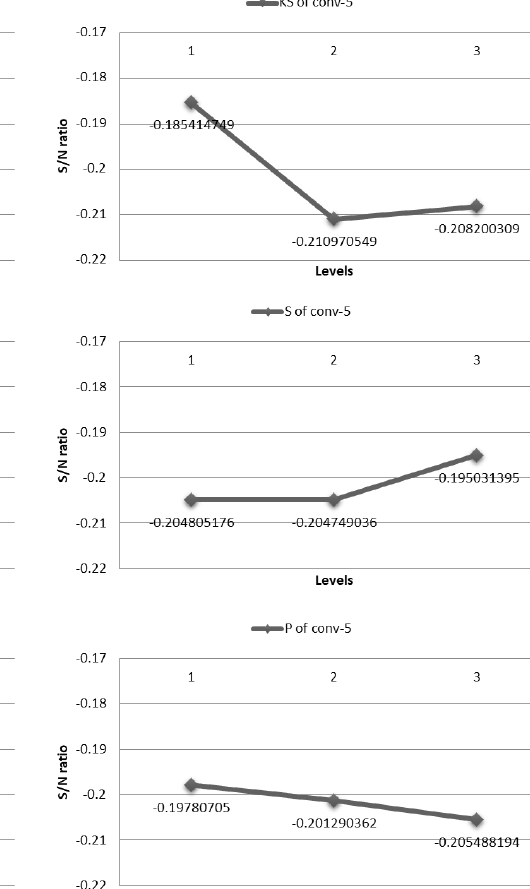
Table 10. Accuracy of the optimal parameter combination in the MORPH